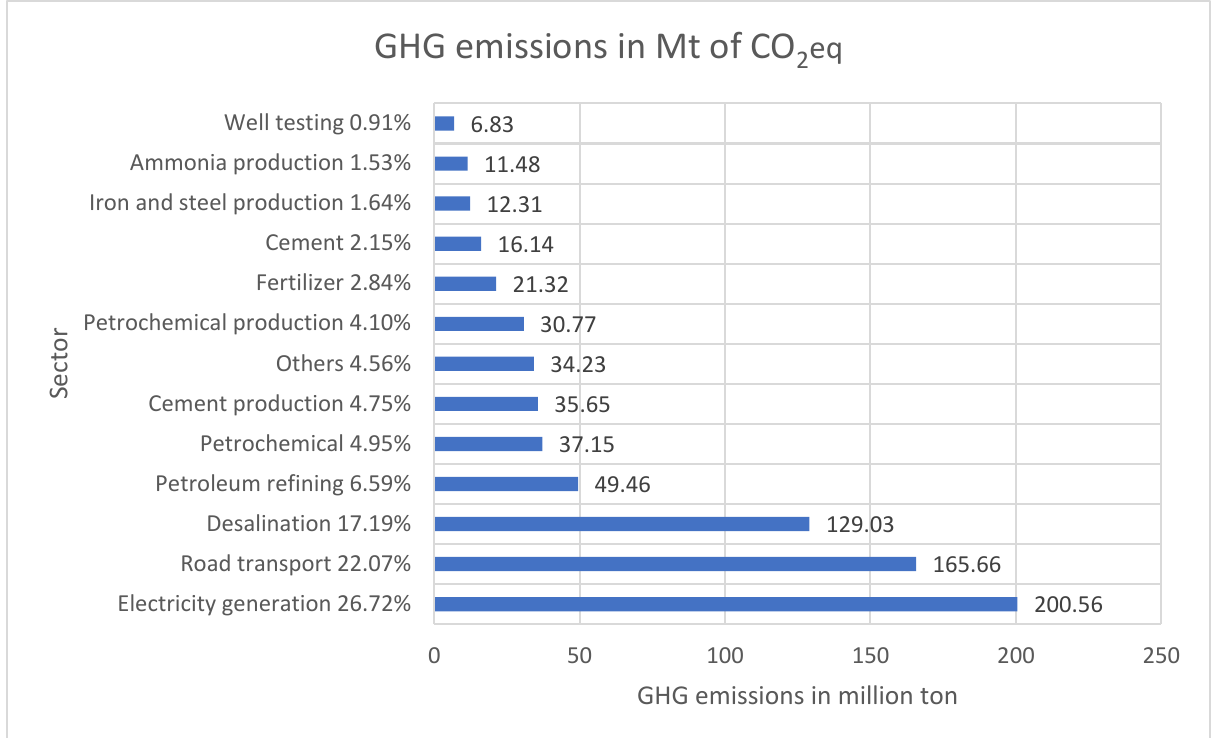
Figure 7. GHG emissions forecast under a business-as-usual (BAU) scenario.